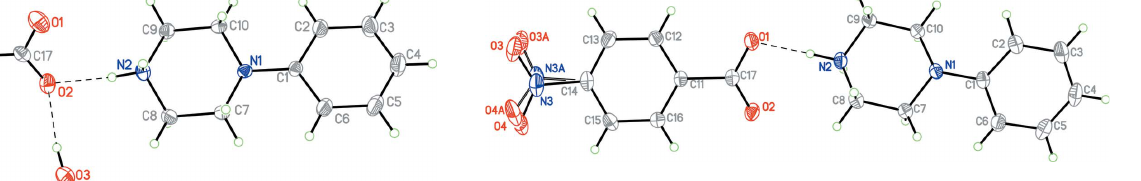
Figure 4 The molecular structure of 5 with hydrogen bonds shown as dashed lines and disorder of the nitro group indicated. Atomic displacement parameters are at the 30% probability